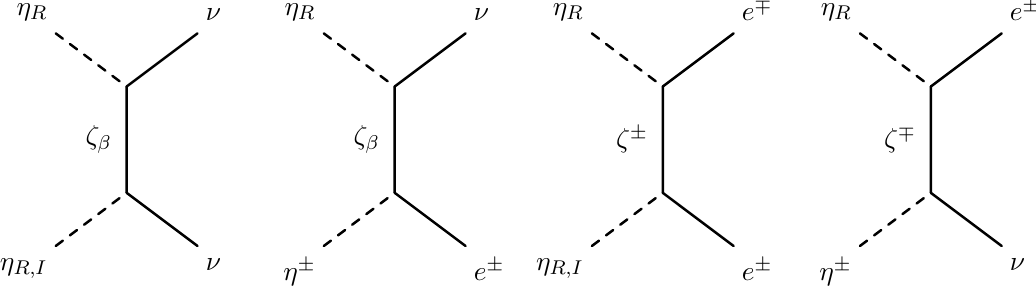
Figure 4 . llustrative Feynman diagrams for scalar annihilation/coannihilation channels involving Yukawa couplings Y N and Y (cid:6)